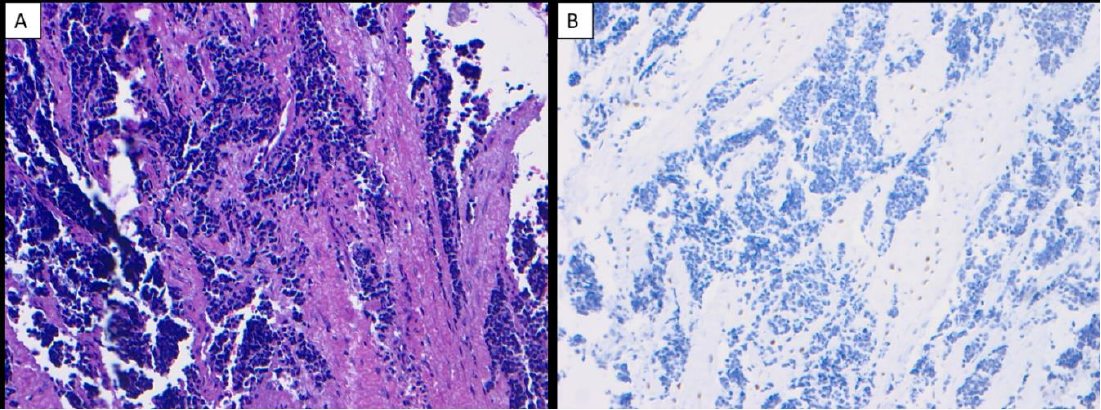
Figure 3. Ewing sarcoma of the jaw (H & E ×200) ( A ), Ewing sarcoma of the jaw showed no nuclear immunoreactivity to SATB2 in any neoplastic cells (×200) ( B ).